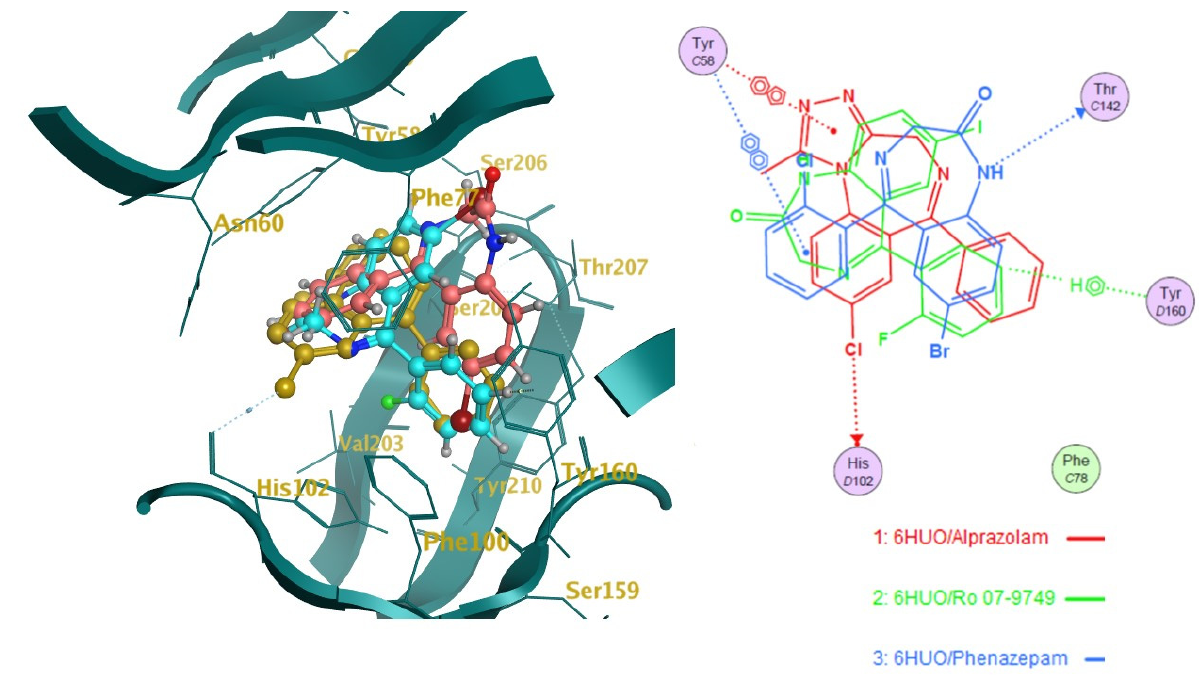
dotted lines showing the H and benzene symbol indicate an arene-hydrogen interaction, while the ones showing the two benzene symbolizes an arene-arene interaction.